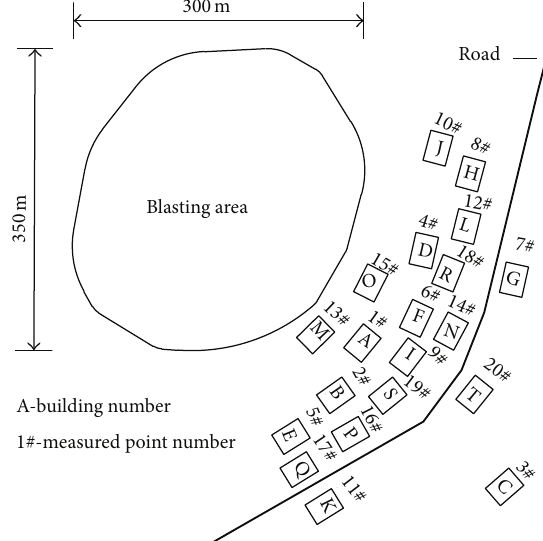
Figure 6: Buildings surrounding blasting